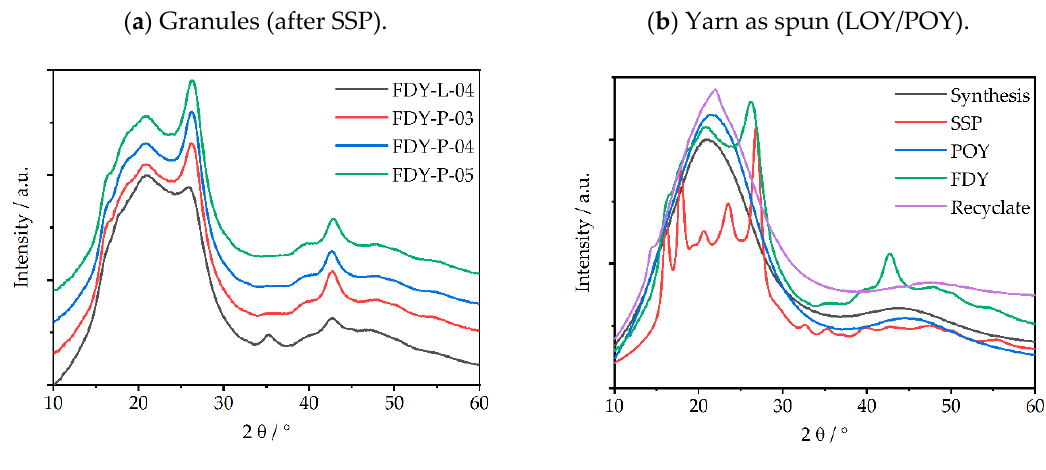
Materials 2021 , 14 , x FOR PEER